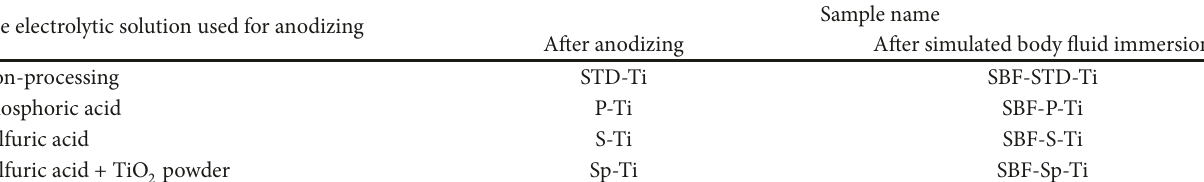
Table 2: Sample names of the prepared Ti plates.